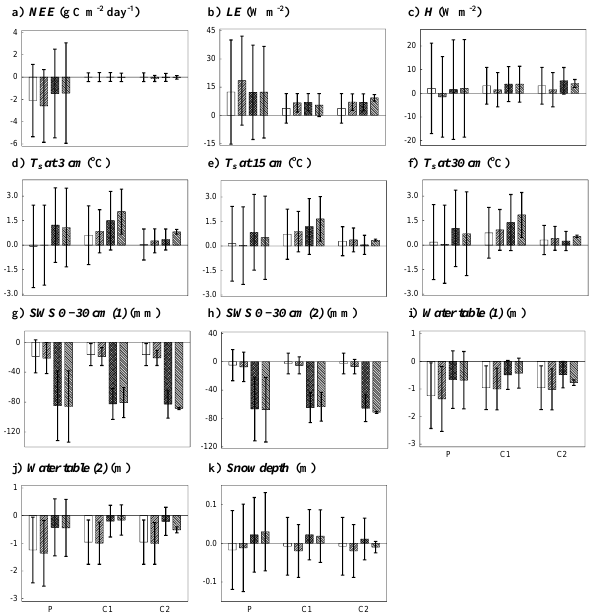
Fig. 5. Statistics on mean error (ME) performance on 11 variables based on DryTs, DryNoTs, MoistTs and MoistNoTs model assumptions when not constrained (posterior (P)) or constrained by C1 or C2, respectively. All bars represent mean values and error bars represent min and max values. For legend see Fig. 4.